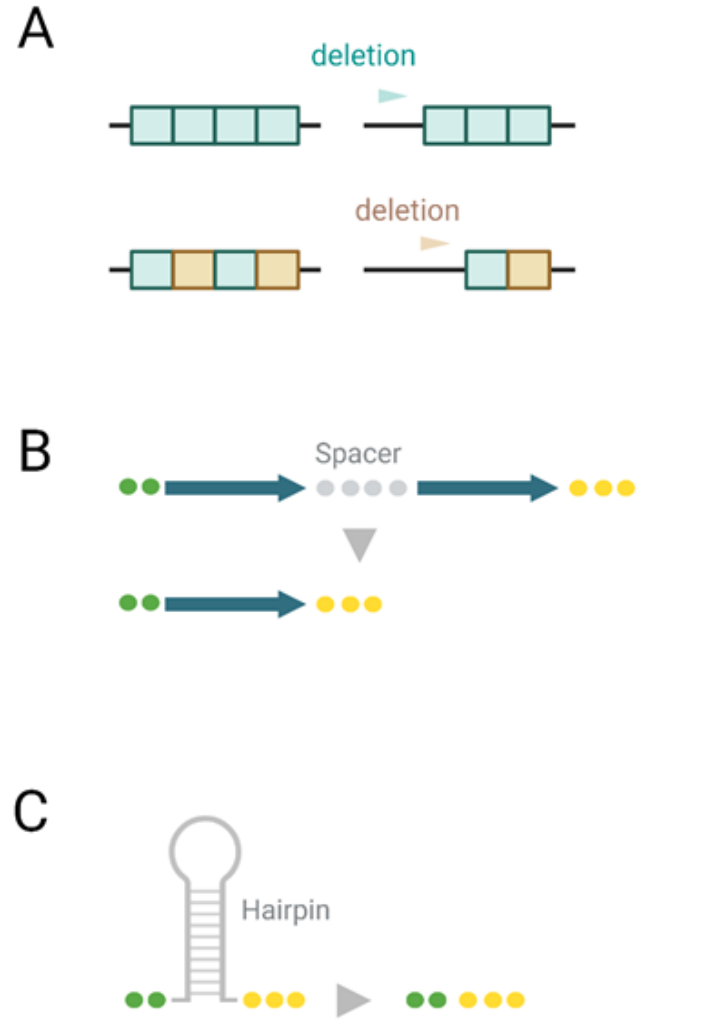
Figure 1. Mechanisms of deletions in DNA. ( A ) Template dislocation model: one (or several) nucleotide deletions in short stretches of identical (poly-)nucleotides. ( B ) Template switch model: deletion between direct repeats that includes the removal of one repeat; ( C ) deletion of hairpin structures.